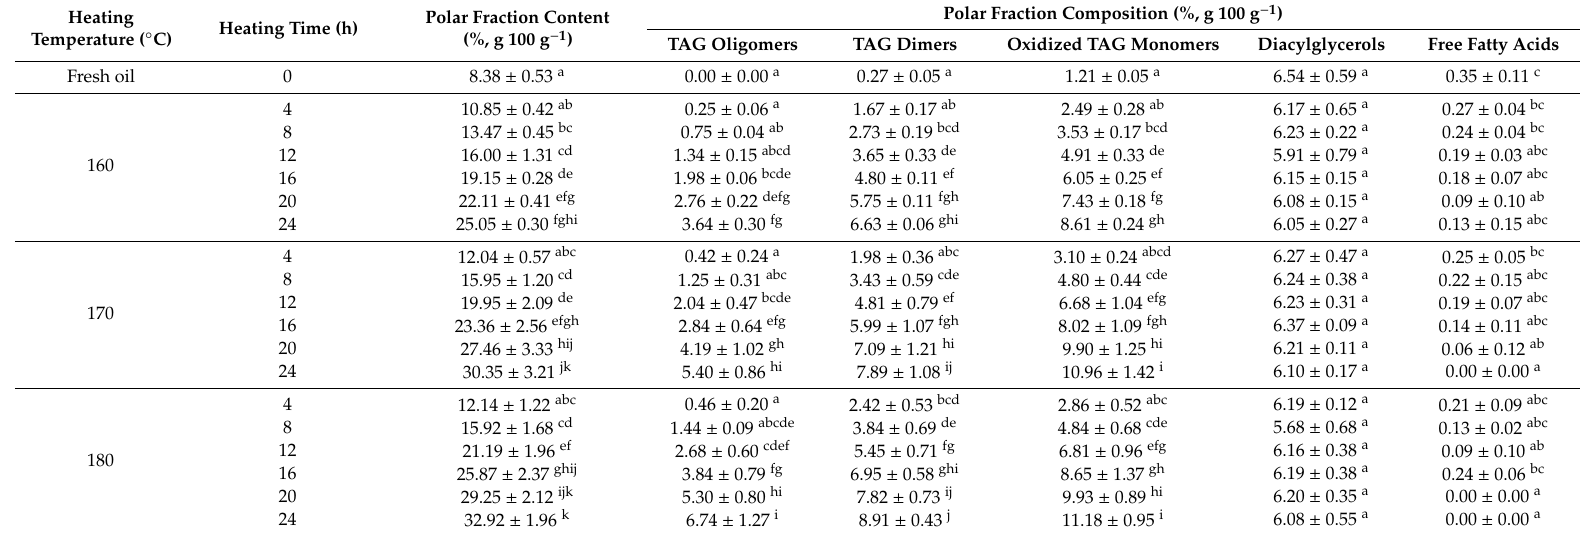
Table 2. Changes in the polar fraction content and composition in palm olein heated at di ff erent temperatures for di ff erent